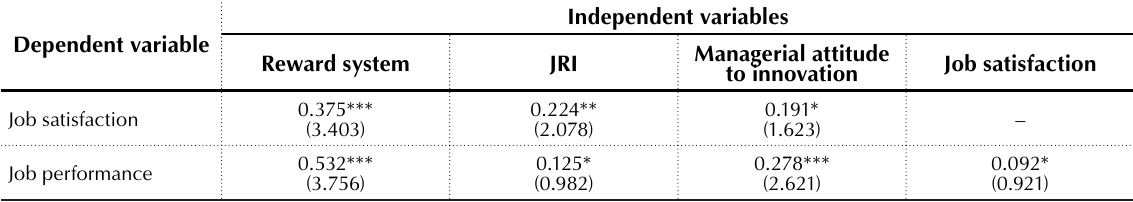
Table 5. Measurement of structural model Dependent